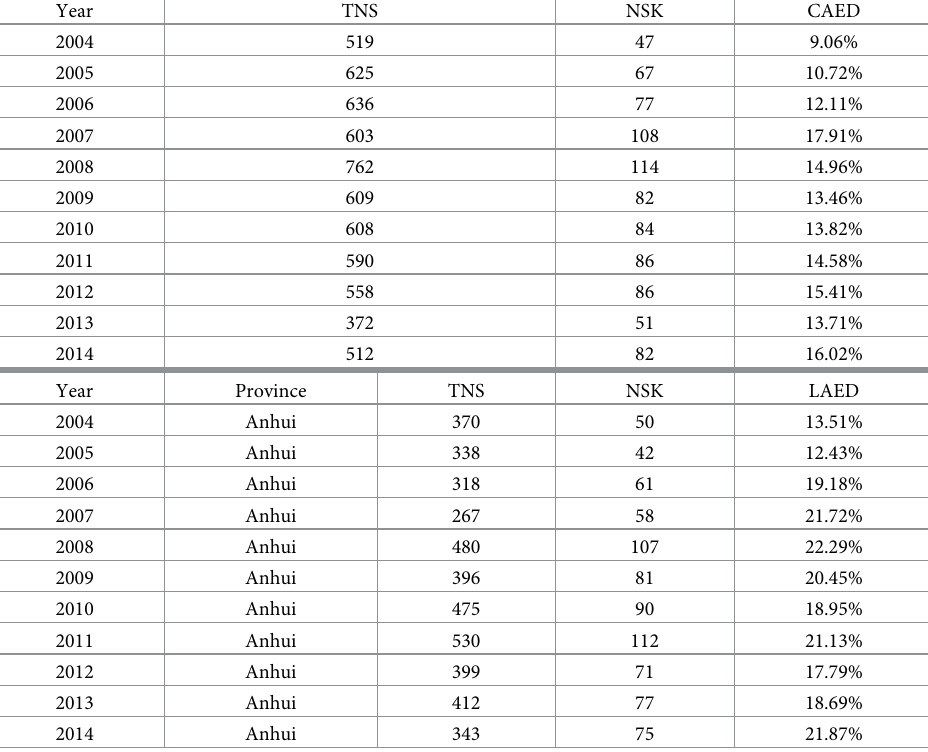
Table 2. (a) AED for the central government (CAED). (b) AED for the local government (LAED, Part).